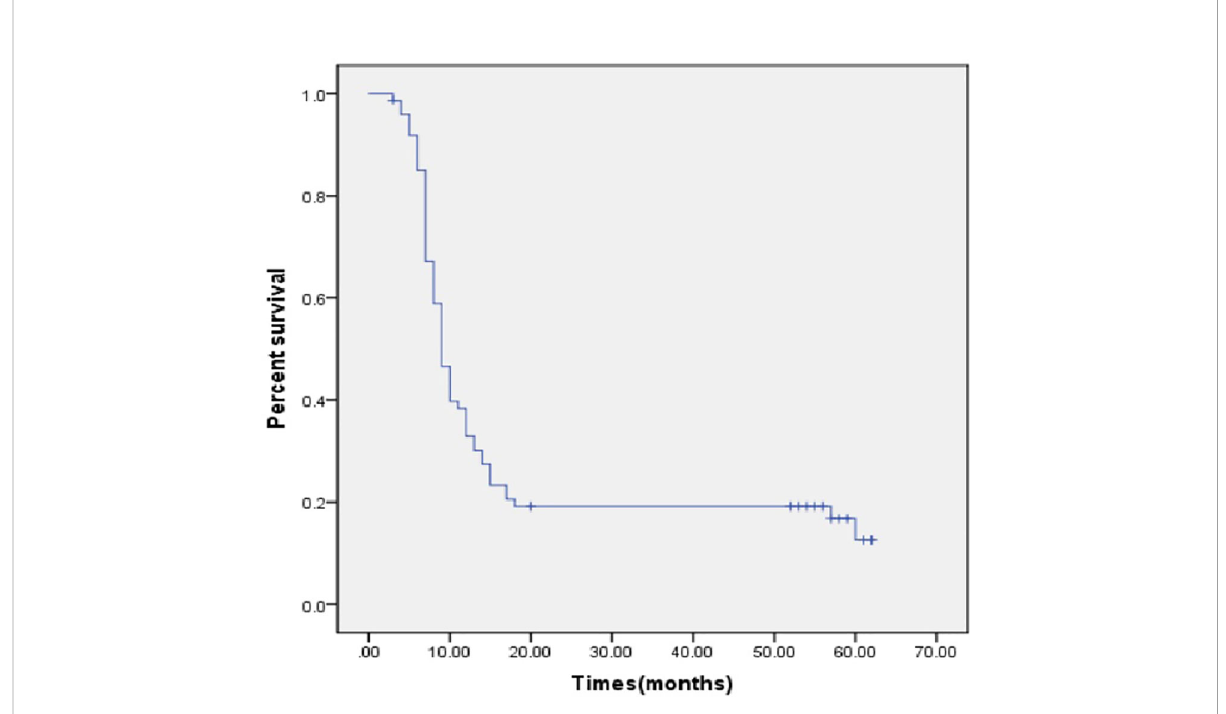
FIGURE 1 Disease free survival in